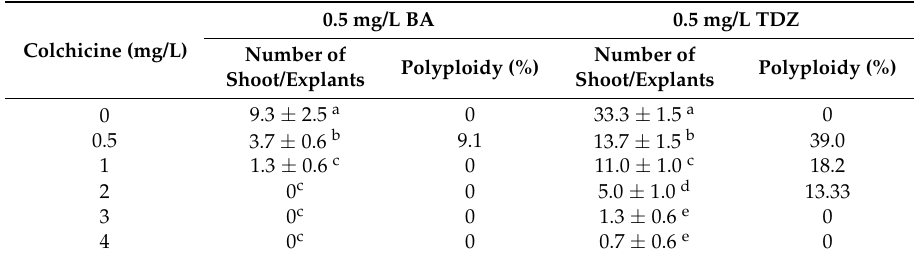
Table 1. Effects of colchicine on shoot formation and subsequent polyploidy induction from the leaf explants of Salvia miltiorrhiza in the presence of N 6 -benzyladenine (BA)